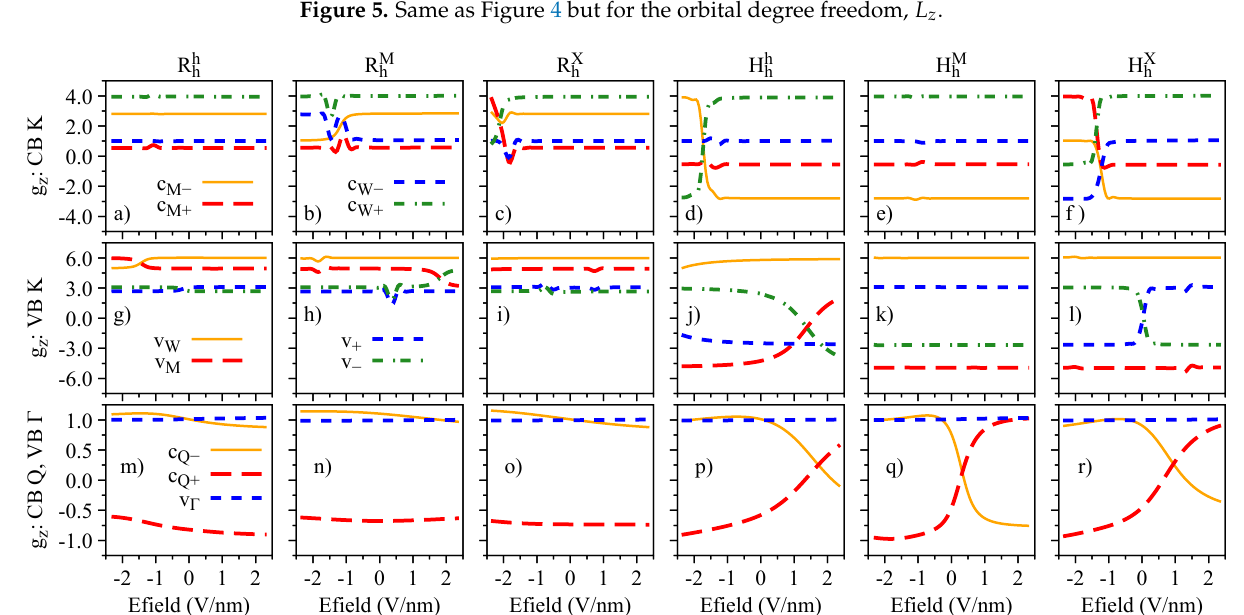
Figure 6. Same as Figures 4 and 5 but for the band g-factor, g z = L z + S z